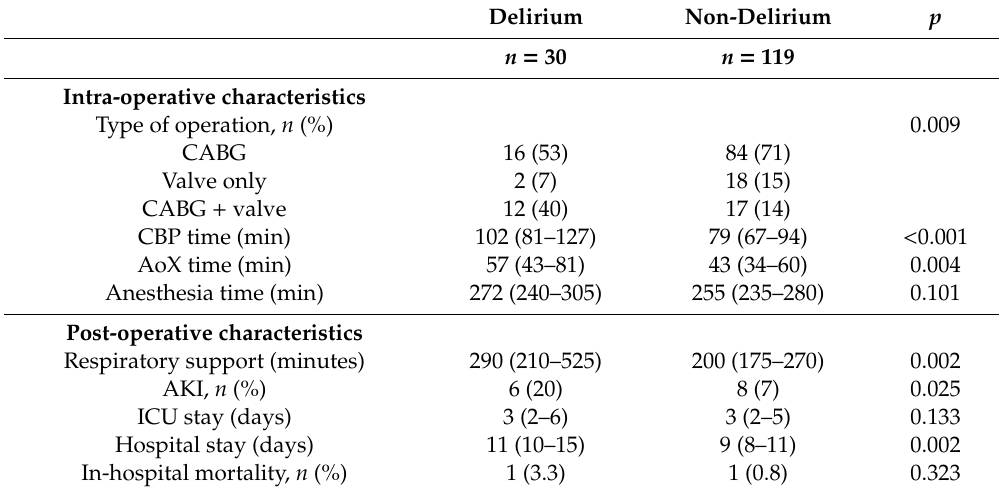
Table 3. Perioperative characteristics: an analysis comparing the characteristics of subjects who developed delirium and those who did